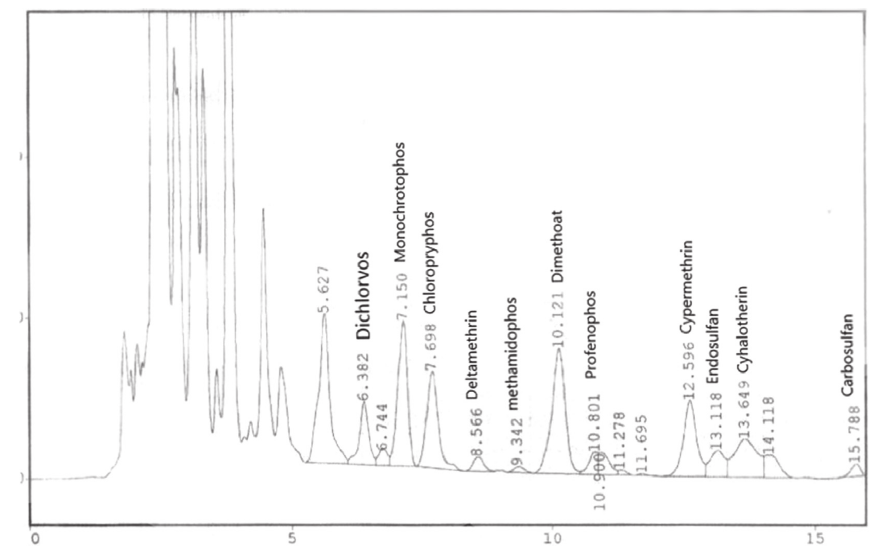
Figure 7: High performance liquid chromatography (HPLC) analysis of